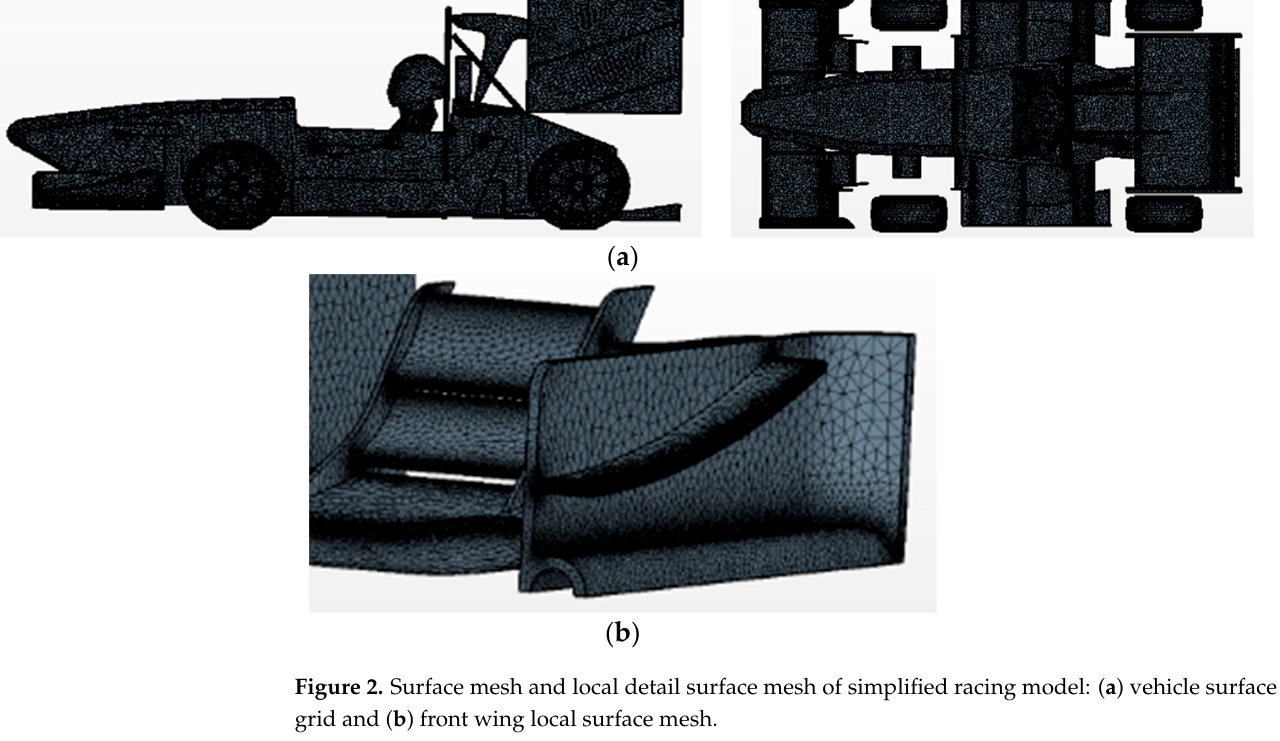
Figure 1. Simplified racing model.